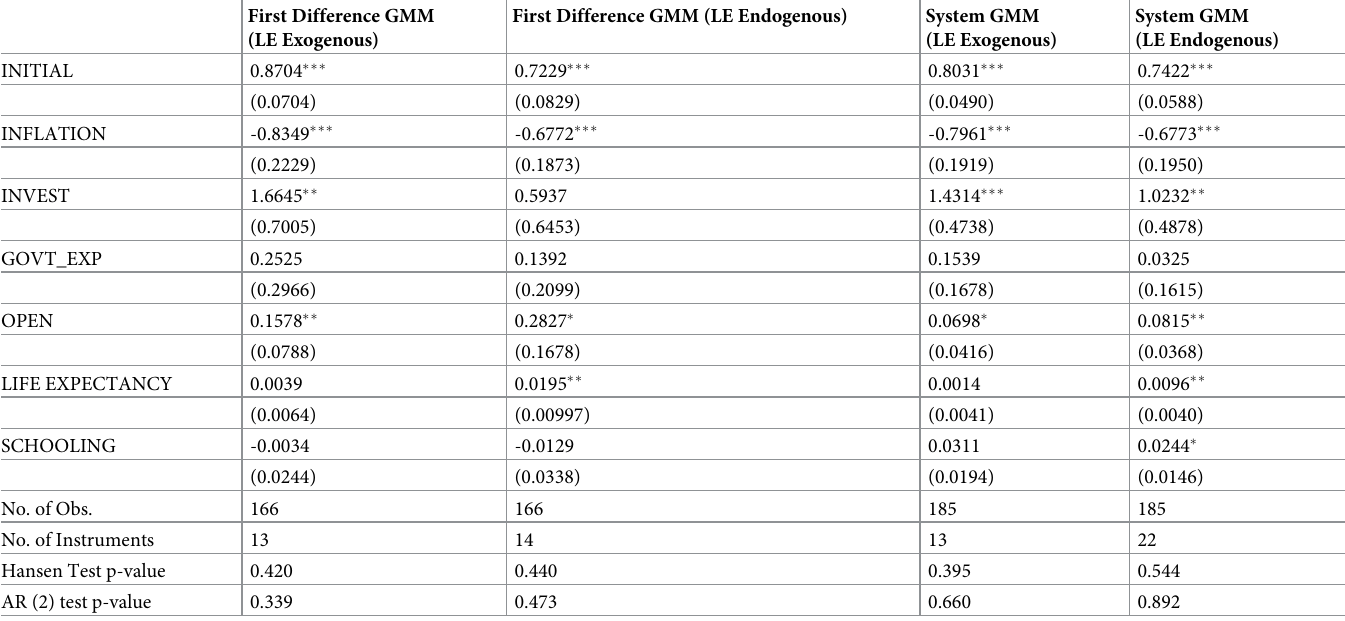
Table 5. Panel GMM results with LogGDP as dependent